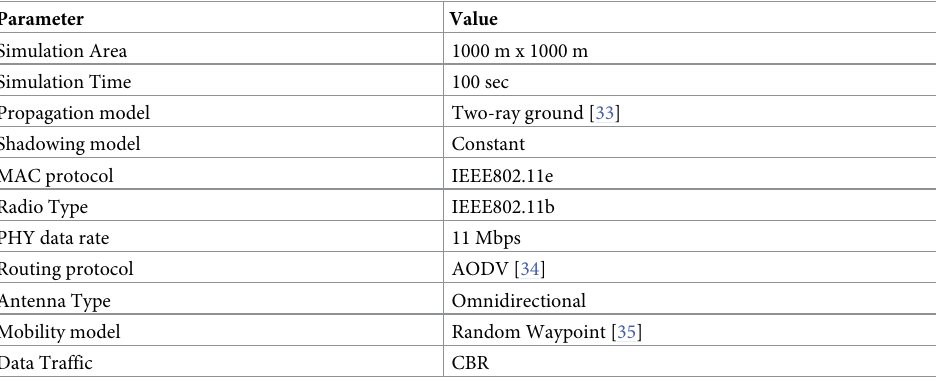
Table 3. Simulation parameters of the EDTXOP